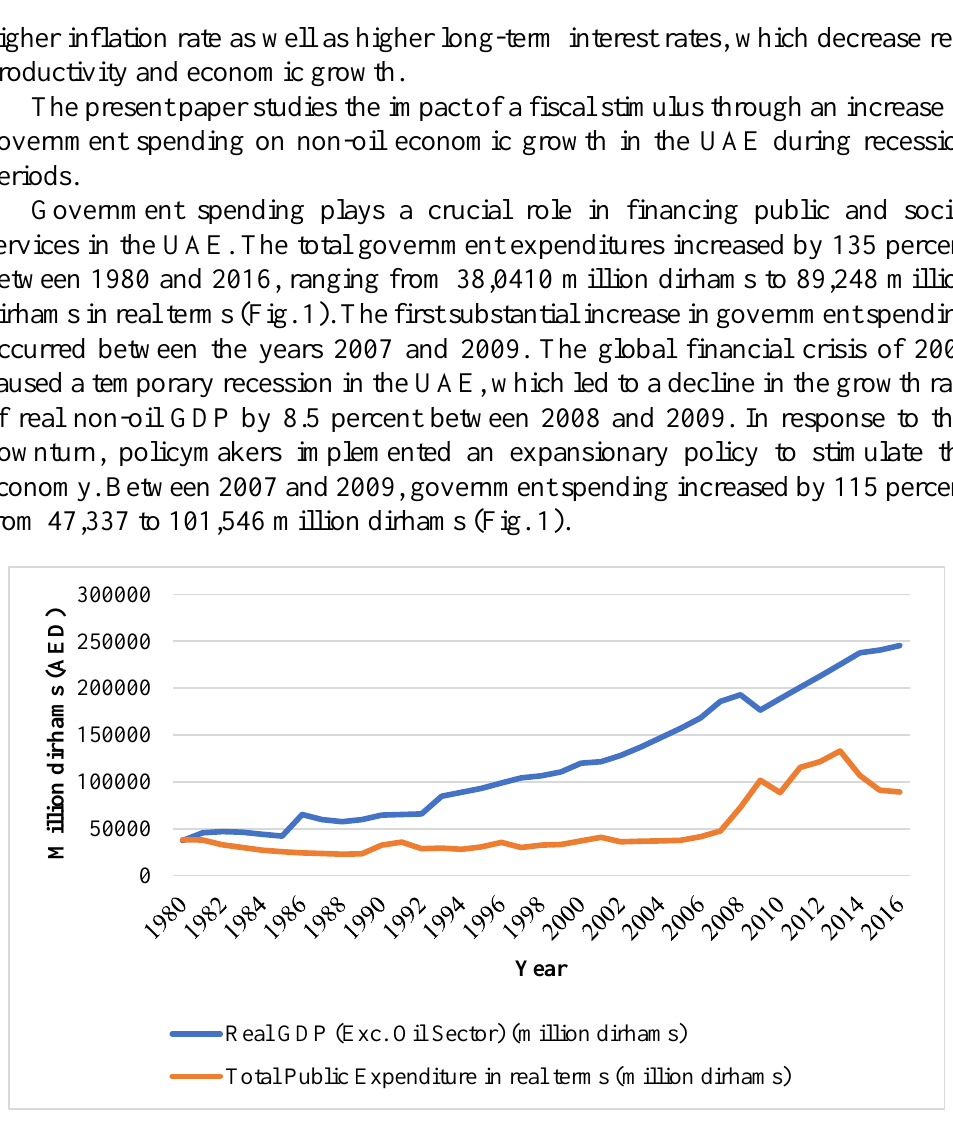
Fig. 1. Government expenditures and non-oil GDP in the UAE during the period 1980–2016 (real values in a million dirhams) (Central Bank of the UAE Publications, Federal Competitiveness and Statistics